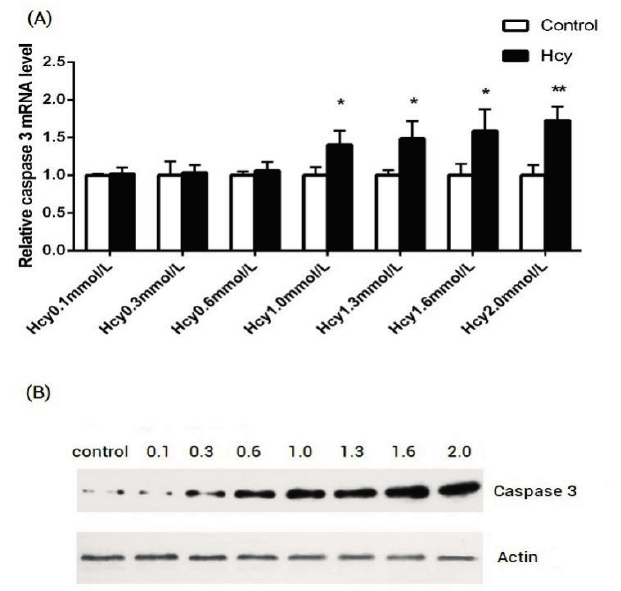
Figure 1. ( A ) The impact on expression of caspase 3 mRNA by different concentrations Hcy on HCAECs. The time of treatment was 24 h. Compared with the control group, * p < 0.05, ** p < 0.01, n = 3 in each group; and ( B ) The impact on expression of caspase 3 protein by different concentrations Hcy on HCAECs. The time of treatment was 24 h. From left to right is the control group, Hcy 0.1 mmol/L group, Hcy 0.3 mmol/L group, Hcy 0.6 mmol/L